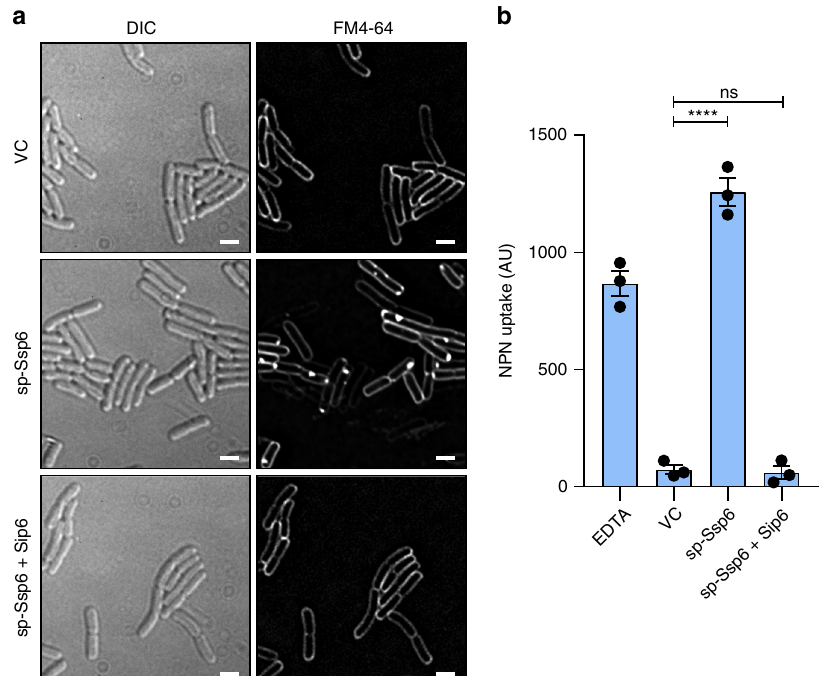
Fig. 5 Ssp6 intoxication affects the outer membrane. a Visualisation of cells of E. coli MG1655 carrying empty vector control (VC, pBAD18-Kn) or plasmids directing the expression of Ssp6 fused with an N-terminal OmpA signal peptide (sp-Ssp6), either alone or with Sip6, using the membrane stain FM4-64 and fl uorescence microscopy. FM4-64 staining was performed following growth in liquid LB containing 0.2% L -arabinose. Panels show DIC image (left) and FM4-64 channel (right). Scale bar 2 μ m. Images are representative of four independent experiments. b Measurement of NPN uptake by E. coli expressing sp-Ssp6 alone or with Sip6, as in part a. NPN accumulation is expressed as arbitrary fl uorescence units (AU) and bars show mean + / − SEM, with individual data points superimposed ( n = 3 independent experiments; **** p < 0.0001, one-way ANOVA with Dunnett ’ s test). Source data are provided as a Source Data fi le.